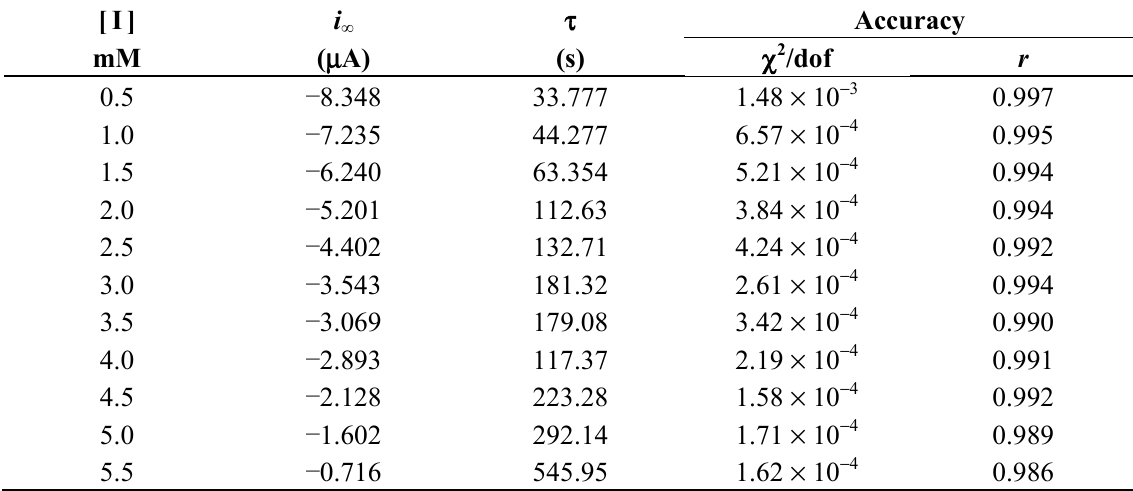
Table S2. The steady-state current ( i phenylhydrazine inhibitor concentrations ([ I